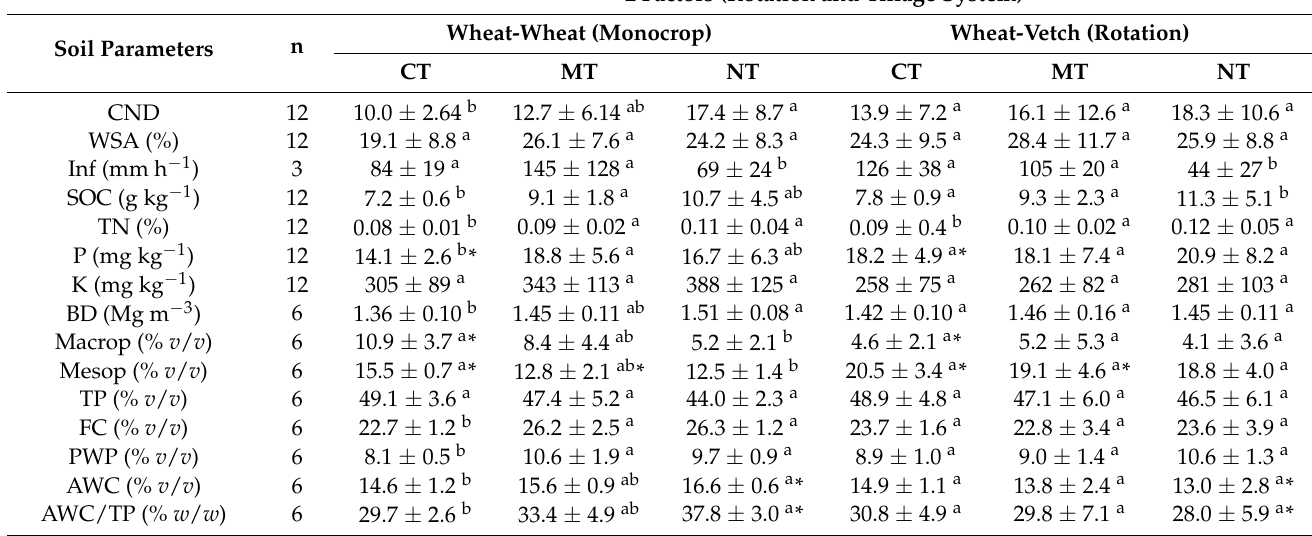
Table 3. Results of Kolmogorov-Smirnov test, showing the influence of tillage and rotation on plots with wheat-wheat monocropping and a wheat-vetch rotation in 2015 and 2016, after 32 years of treatments in 0 to 20 cm of soil thickness. Significant differences are marked at p < 0.05. Average values and standard deviation are stated. Different letters in each row indicate differences between different tillage types for the same cultivation system (monocrop or rotation); any differences found between rotation systems under the same tillage system are marked by an asterisk